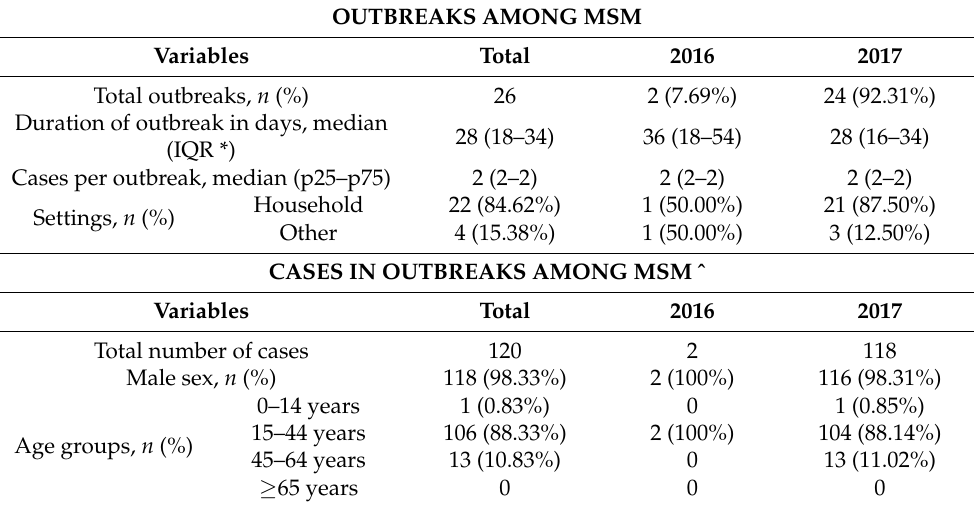
Table 1. Epidemiological characteristics of hepatitis A outbreaks among MSM and related cases,